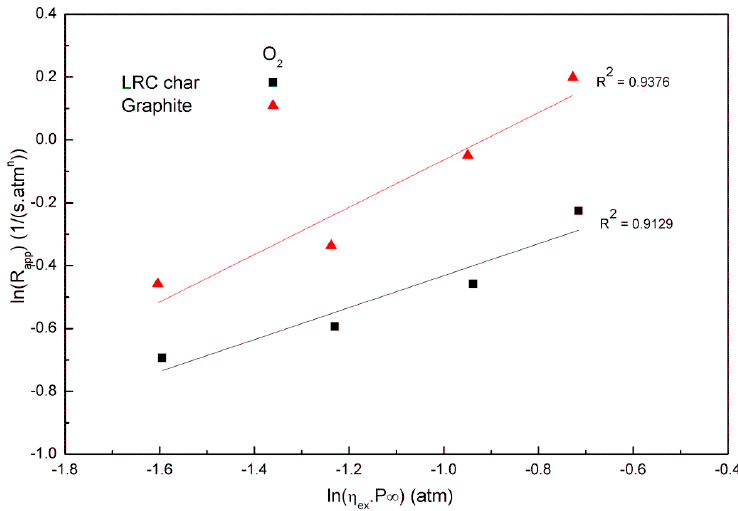
Figure 5. n th order Arrhenius plots for low-rank coal char and graphite.